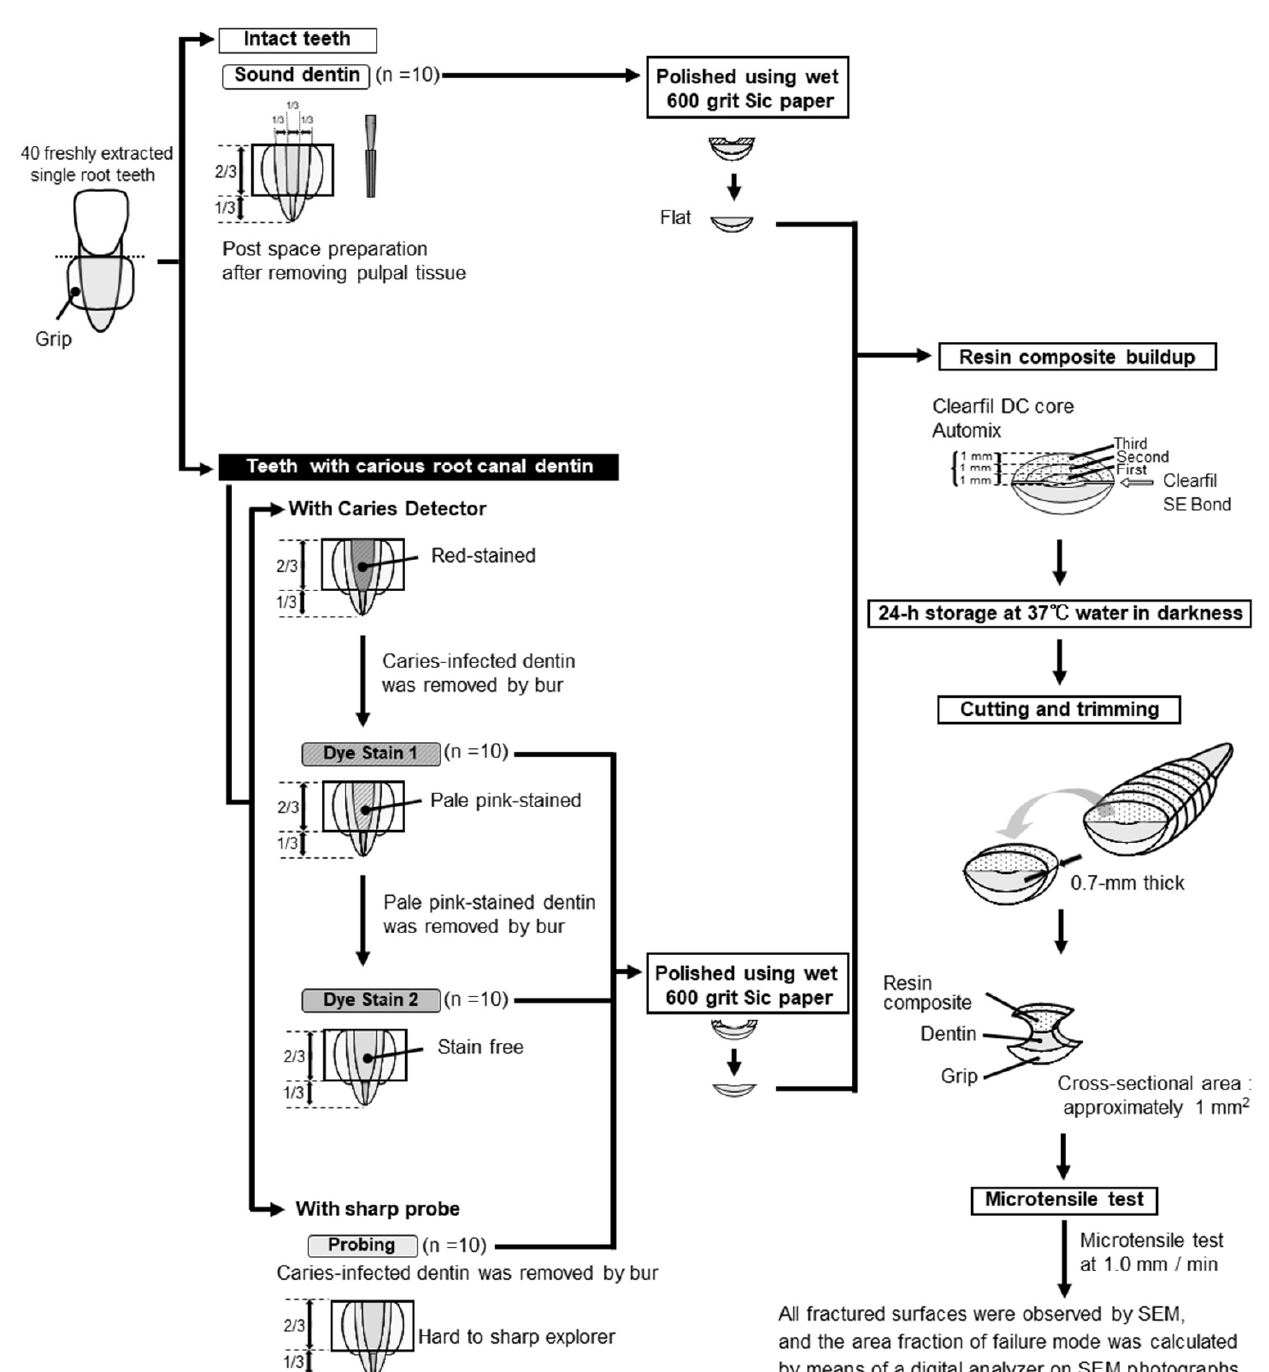
Figure 1. Schematic showing the experimental procedure for microtensile